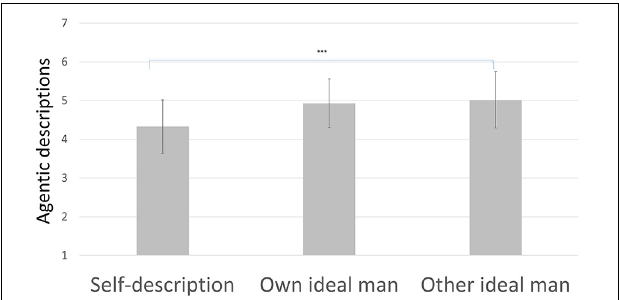
FIGURE 2 | Agentic descriptions in Study 1, with SD error bars ( ∗∗∗ indicates p < 0.001).